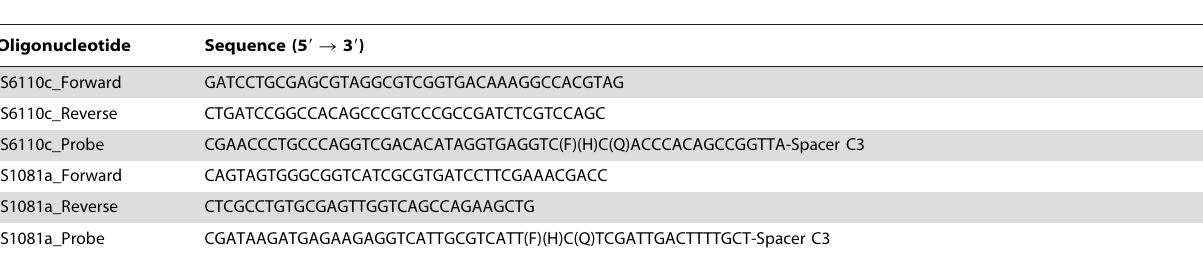
Table 2. Oligonucleotide primers and